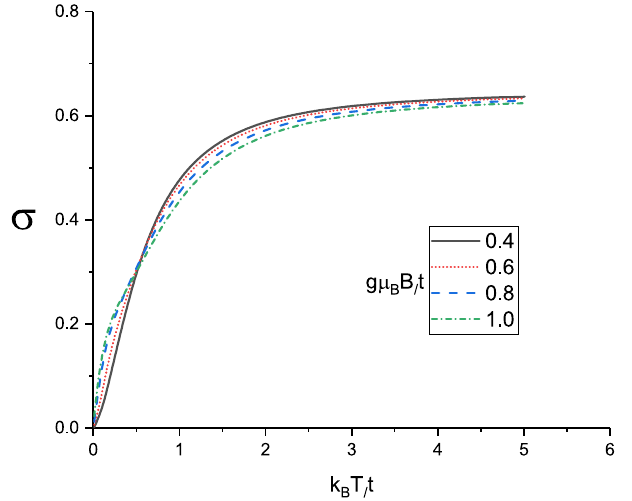
Figure 8. Electrical conductivity of Lieb lattice as a function of normalized temperature k B T / t for different values of normalized magnetic field g µ B B / t at fixed gap parameter �/ t = 0.3 . Normalized chemical potential and normalized spin-orbit coupling strength have been fixed at µ/ t = 1.0 and (cid:31) / t = 0.2 , respectively.